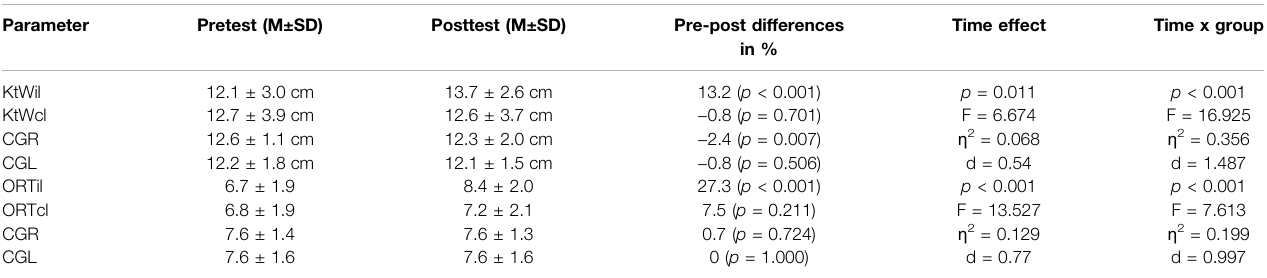
TABLE 5 | Descriptive statistics and two-way ANOVA of ROM tests. Parameter